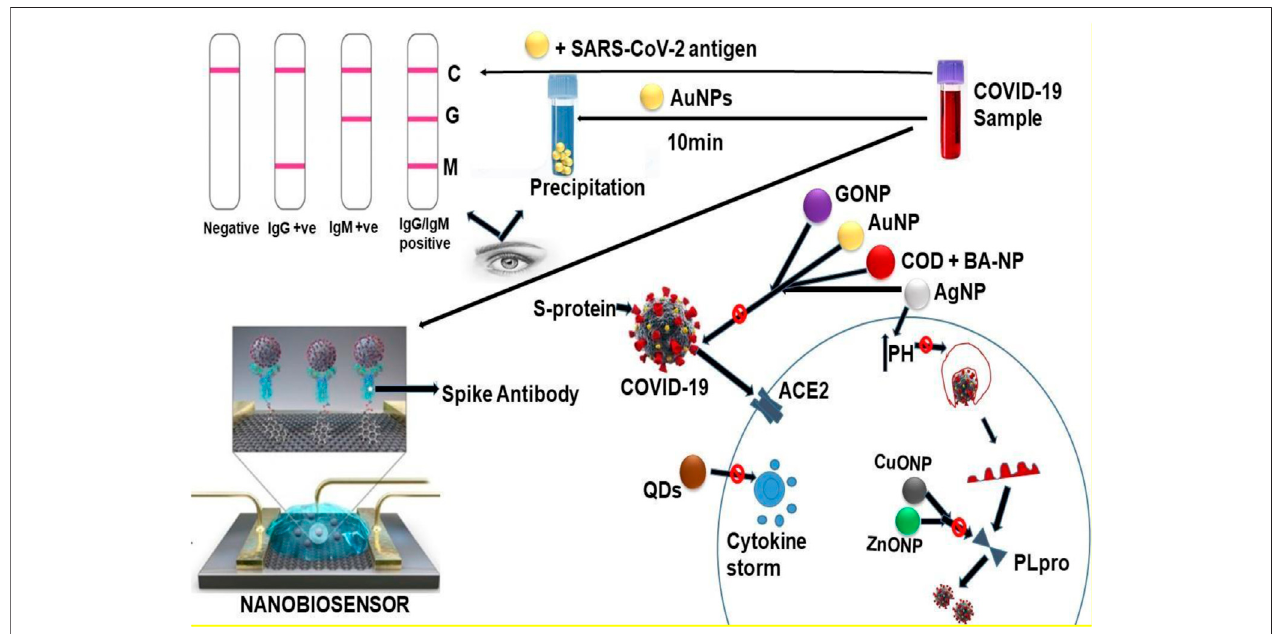
FIGURE 3 | The schematic presentation of the interaction between the components of SARS-CoV-2 and various nanoparticles. GONP (cid:1) Graphene oxide nanoparticle AuNP (cid:1) Gold nanoparticle COD-NP (cid:1) Carbon oxide nanoparticle c BA-NP (cid:1) Boric acid nanoparticle CuONP (cid:1) Copper oxide nanoparticle AgNP (cid:1) Sliver nanoparticle ZnONP (cid:1) Zinc oxide nanoparticle QDs (cid:1) Quantum dots.